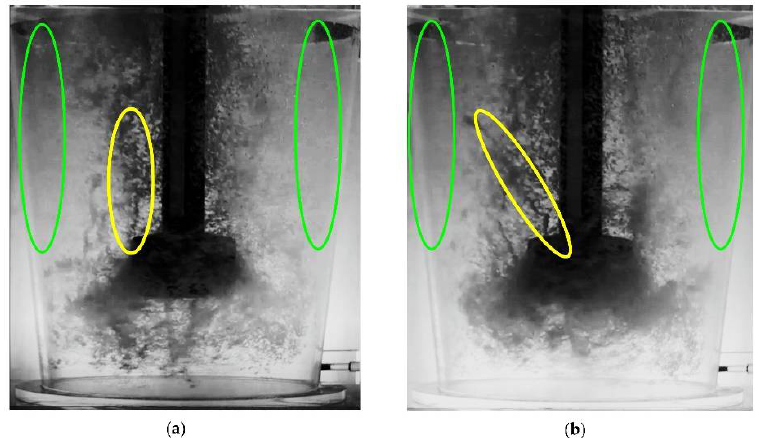
Figure 6. Characteristic features of excessive dispersion (creation of swirls in yellow and dead zones–no dispersion in green) for different variants of experiments: ( a ) 550 rpm, 12 dm 3 ∙min −1 ( b ) 550 rpm, 17 dm 3 ∙min −1 .